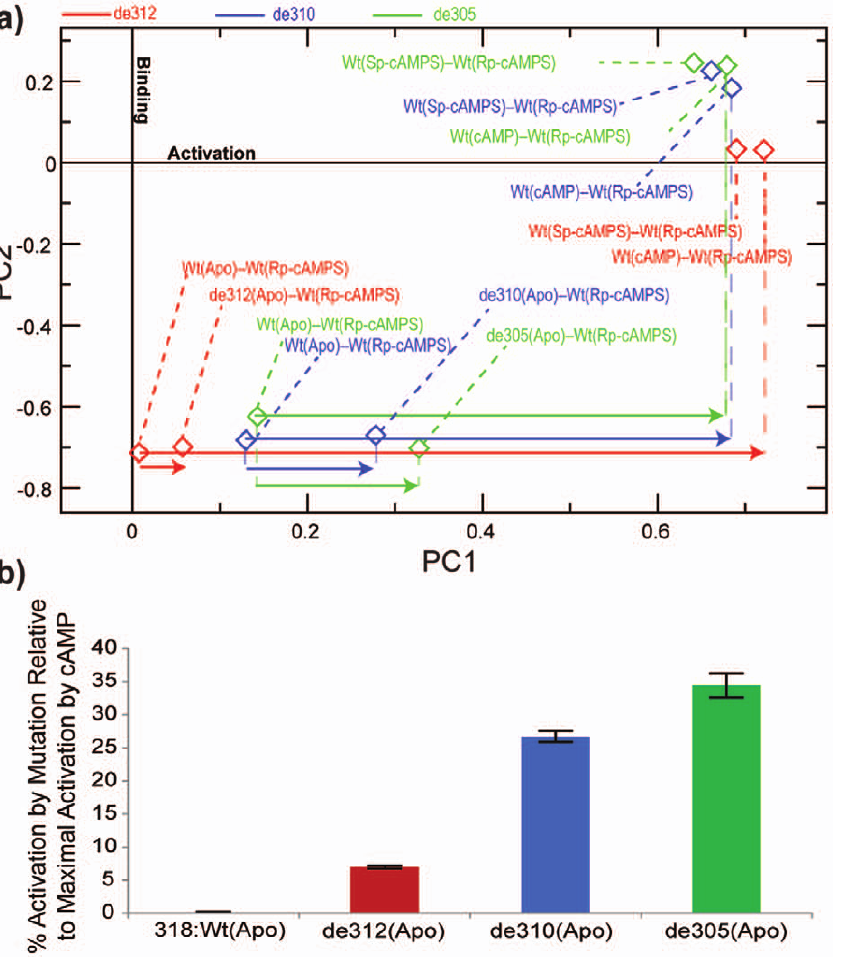
Figure 4. SVD analysis of the chemical shifts measured for the C-terminal truncation mutants de305, de310 and de312. a ) This panel shows the PC1 vs. PC2 plot with three sets of loadings (diamonds) for each of the C-terminal hinge helix deletion mutants: de312 (red), de310 (blue) and de305 (green). There are four loadings per mutant with each loading corresponding to a state referenced to Rp-cAMPS, as labelled in the figure. The smaller arrows correspond to the separation along PC1 between the Wt(apo) and the mutant(apo) state. The large arrows correspond to the separation along PC1 between the Wt(apo) and the cAMP-bound Wt(holo). b ) The percentage ratio of the two separations measured in panel (a) ( i.e. relative magnitude of the two arrows), provides a quantitative measure of the overall fractional shift toward activation caused by the